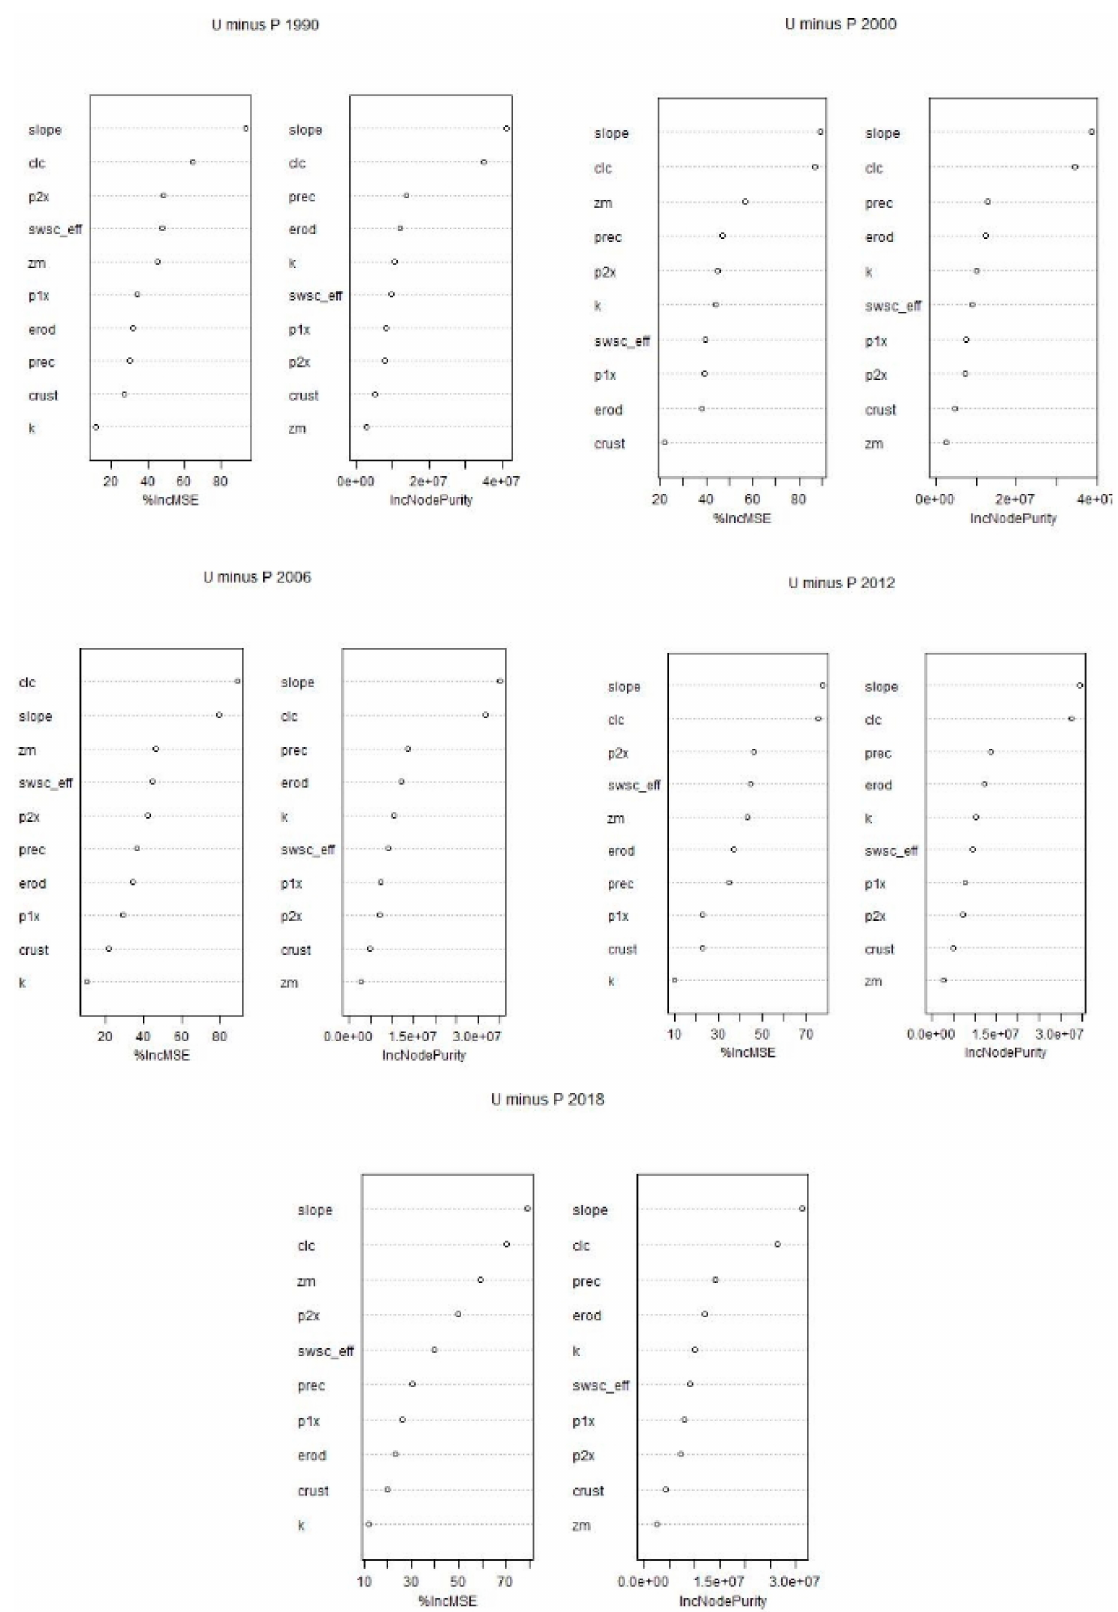
Figure A5. Variable importance based on Random Forest regression for the di ff erences between the USLE (U) and PESERA (P) models for all modeled